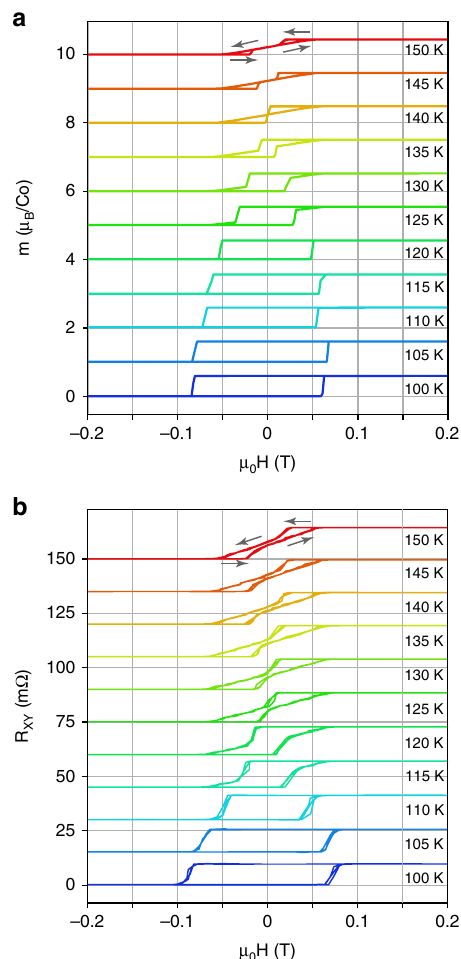
Fig. 4 Magnetic hysteresis at intermediate temperatures with fi eld parallel to the c-axis. The samples were cooled in an applied fi eld μ H ¼ 0 : 5 T showing the magnetic hysteresis loops for temperatures near 0 125 K. a Magnetization as a function of applied magnetic fi eld. The square shape of the loop at 100 K gradually changes to a bipartite transition. b R as a function of applied magnetic fi eld. The square, AHE characteristic shape at 100 K gradually changes to a bipartite transition with almost no hysteresis at zero fi eld. The fi eld value of the hysteresis step continuously evolves from positive to negative fi eld upon lowering temperature with the temperature at which it crosses zero fi eld corresponding to the step in the AHE seen in Fig.